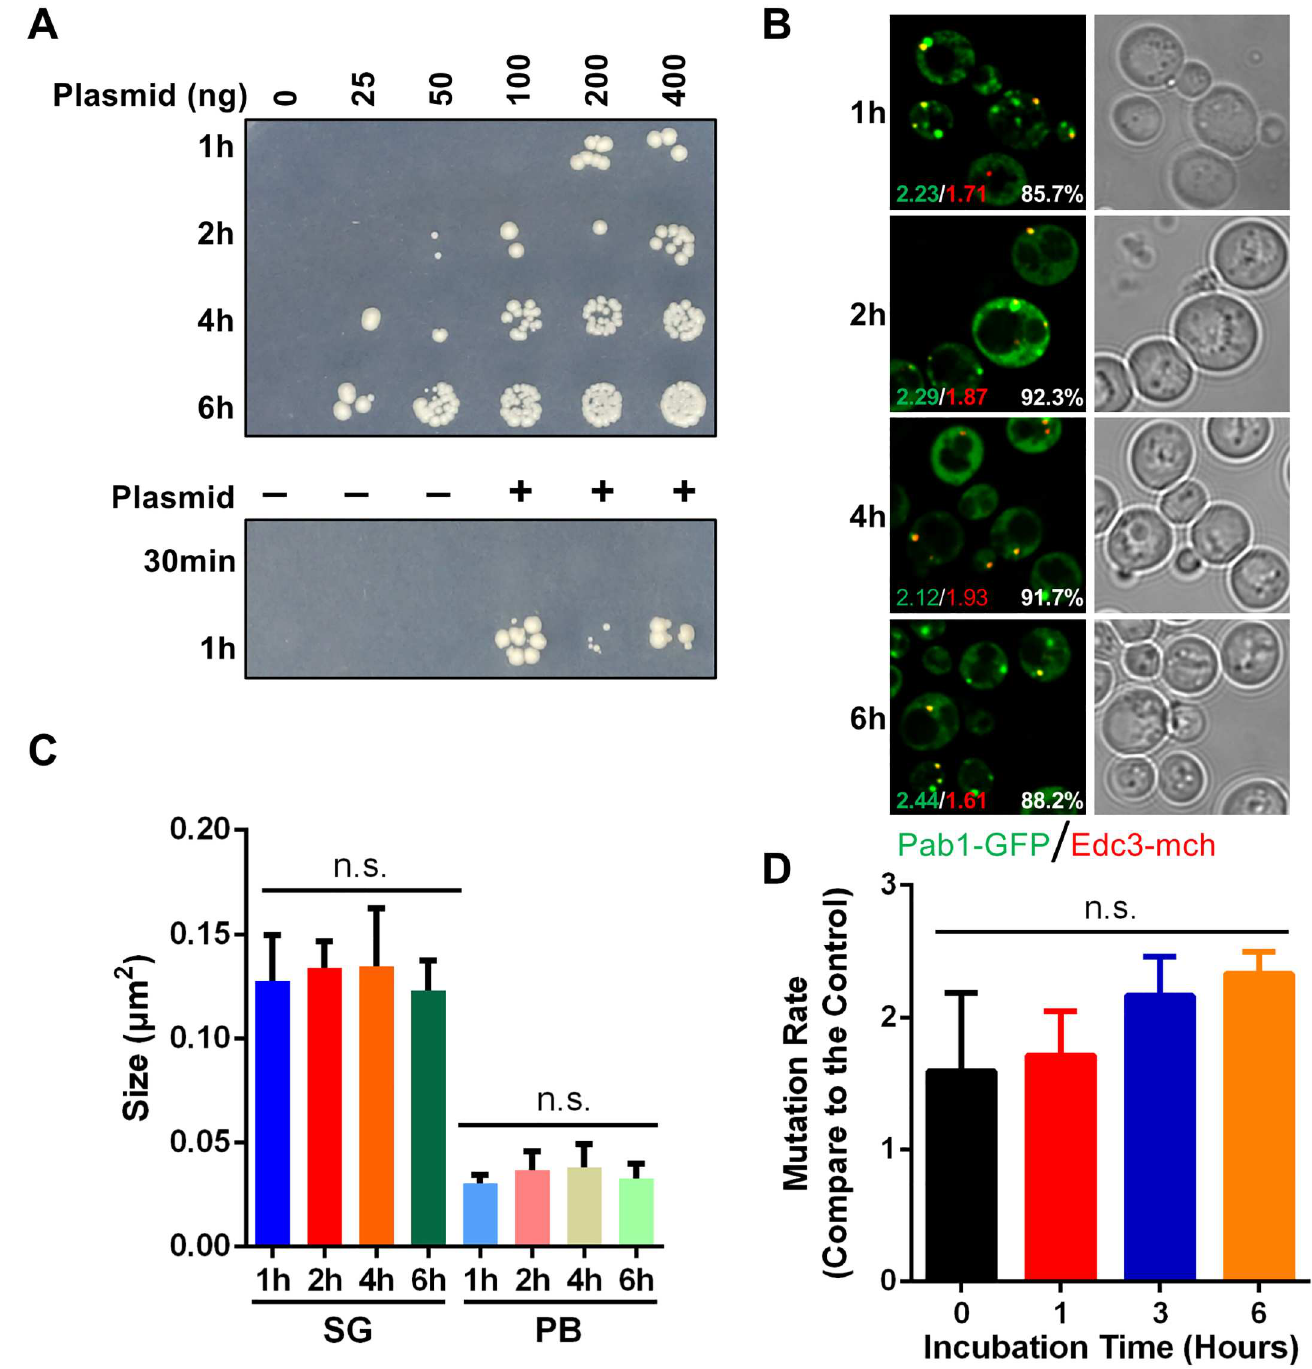
Fig 2. Transformation efficiency is increasedwith extended 42˚C heat shock periods. (A) BY4741cells at OD 600 0.5 were transformed with the indicatedamount of pRB1 plasmidand incubatedat 42˚C for 30 minutes (min), 1, 2, 4, and 6 hours (h). Transformants were selectedon –Uracilplates. (B) Transformed cells generatedfrom transformation reactions with different 42˚C incubationtimes (1, 2, 4 and 6 hours). Numbers indicateaverage stress granule(Pab1-GFP, green text) or P-body (Edc3-mCh, red text) foci per cell, and the percentageof Edc3-mCh foci co-localized with Pab1-GFP (white text). (C) Quantification of stress granule(SG) and P-body (PB) size in (B). Data is presented as mean ± standarddeviationof 3 independent experiments; n.s., not significant.(D) BY4741cells transformed with pRB1 plasmidand incubatedat 42˚C for different time were assessed for elevated mutation rates by development of canavanine resistance. Transformed cells were plated on canavanine media (60 mg/L). Simultaneously, 1/200 diluted amount of cells were coated on the YPD plate. Colonynumberwas countedafter 2 days incubationat 30˚C. Mutation rates were normalizedto the 0-hour heat shock. Data is presented as mean ± standarddeviationof 3 independent experiments; n.s., not